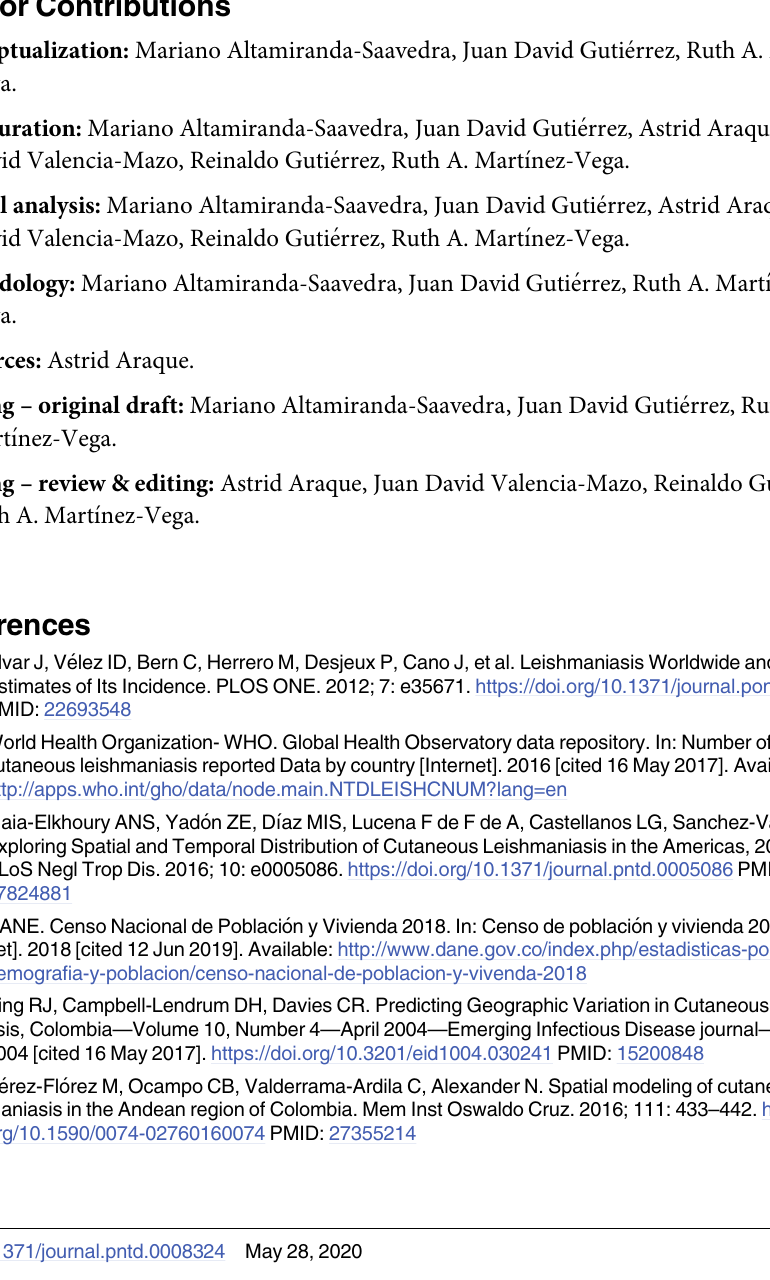
S1 Table. Episodes of the ENSO cycle between 2007 and 2016 according to the ONI index values of the National Oceanic and Atmospheric Administration. S2 Table. Relationship between occurrence of at least one CL case in each locality and the percentage of local area with a richness of vectors, Norte de Santander (n = 1,588 localities) � . S1 Fig. Uncertainty of the records without specific coordinates used in the potential distri- bution